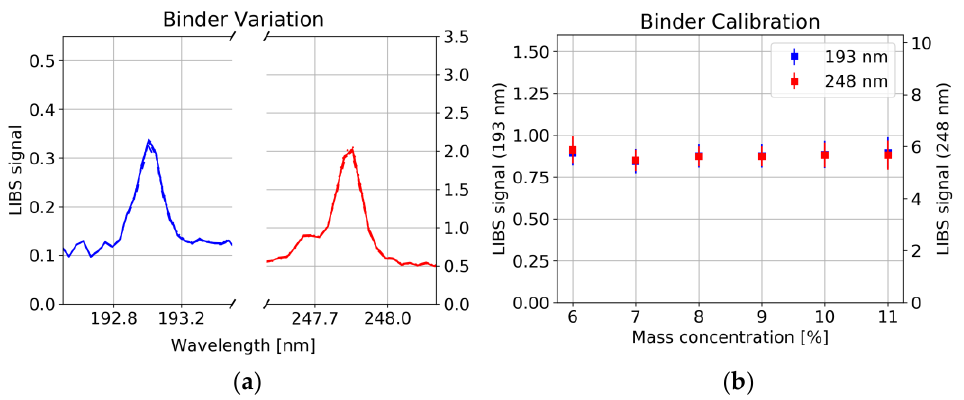
Figure 9. ( a ) Carbon lines (std normalized) for different concentrations of binder (NMC111 6 mJ) and 6% graphite/carbon black. ( b ) LIBS signal for six samples with different Binder concentrations, error bars from 25 samples (25 spectra averaged for each sample).